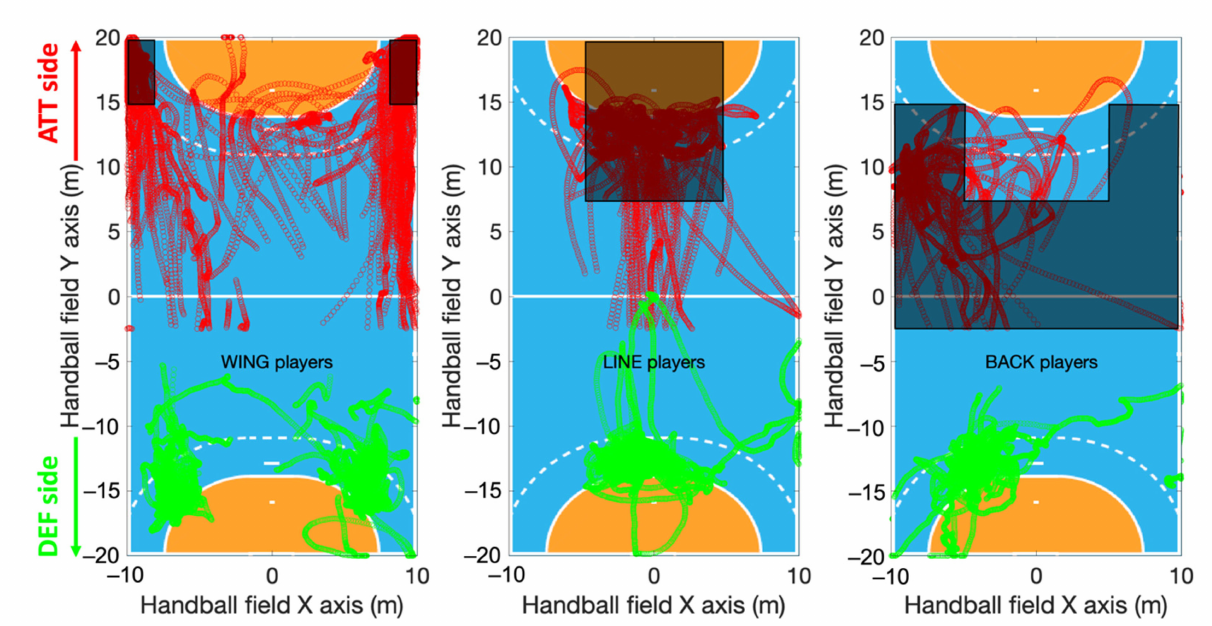
Figure 2. Detection of the players main roles based on their highest density of positions during ATT phases (in red). Classification of wing players occurs if the highest density of position corresponds to a black rectangle of 5 m long and 2 m wide on the wings ( left panel). Classification of line players occurs in a zone of 10 m wide for 12.5 m long (black rectangle in the middle panel). Classification of back players occurs if the highest density is reported in the black zone of the field ( right panel). As a supplementary visual indication, positions of each player during DEF phases were also depicted (in